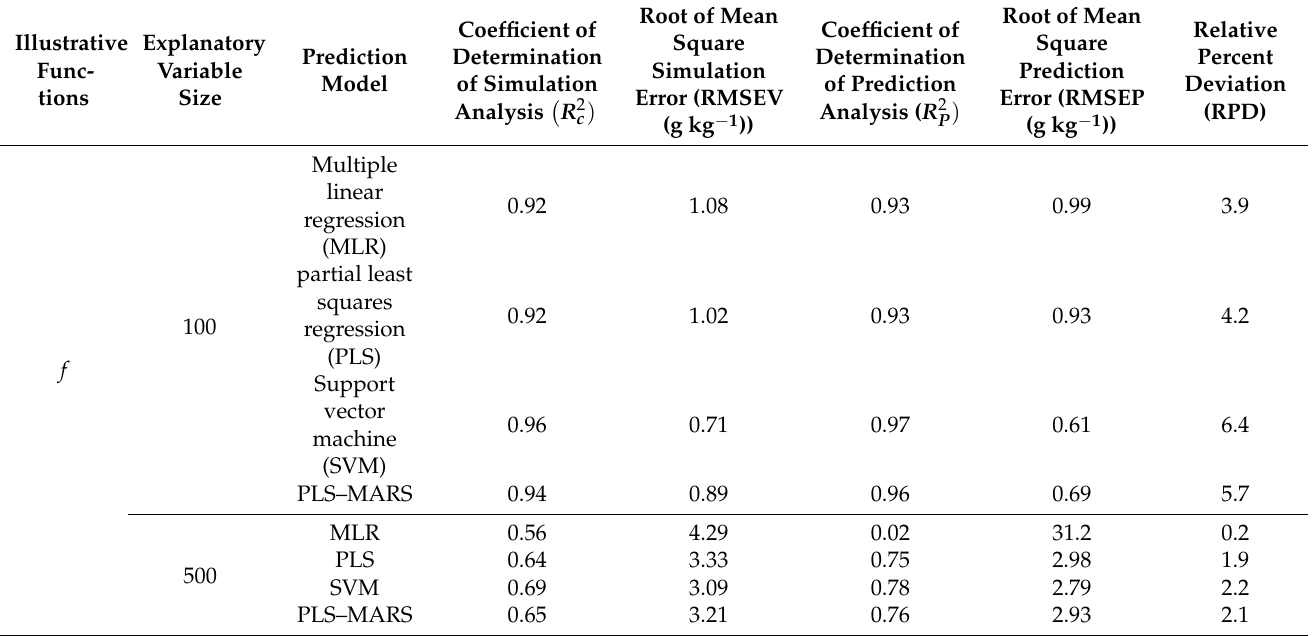
Table 2. Evaluation results of typical prediction models for the illustrative